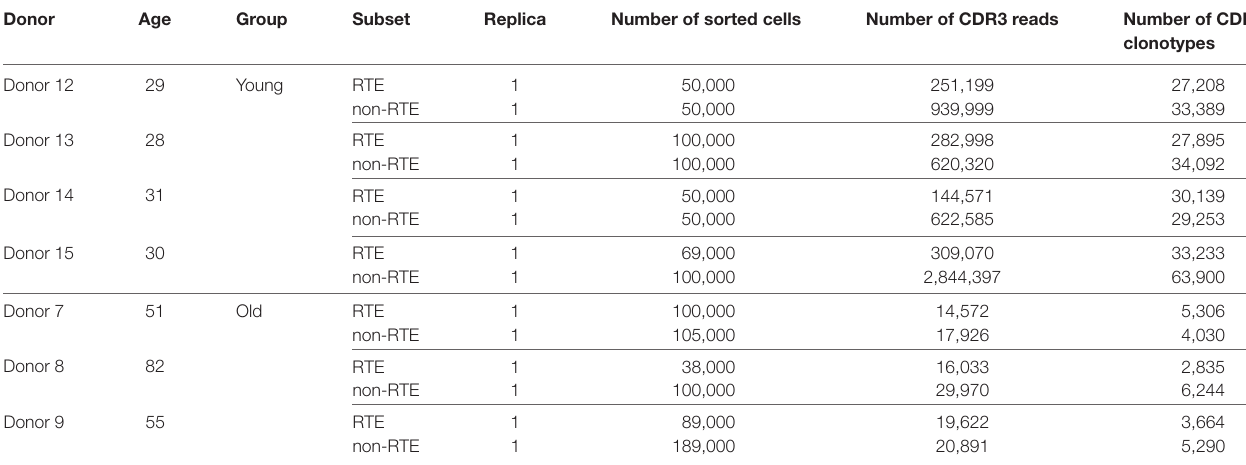
Table 3 | Recent thymic emigrants (RTEs)-enriched and mature naïve CD4 T cell